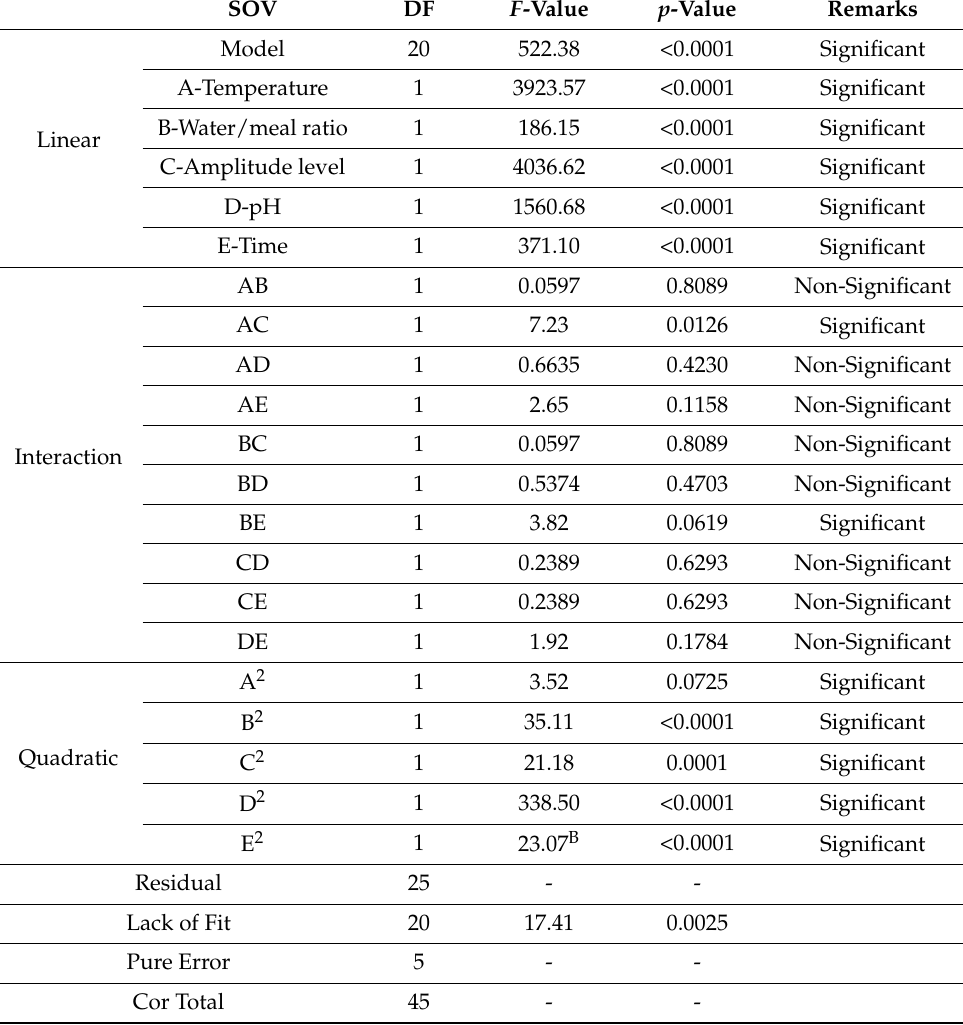
Table 4. Analysis of Variance (ANOVA) for PSG